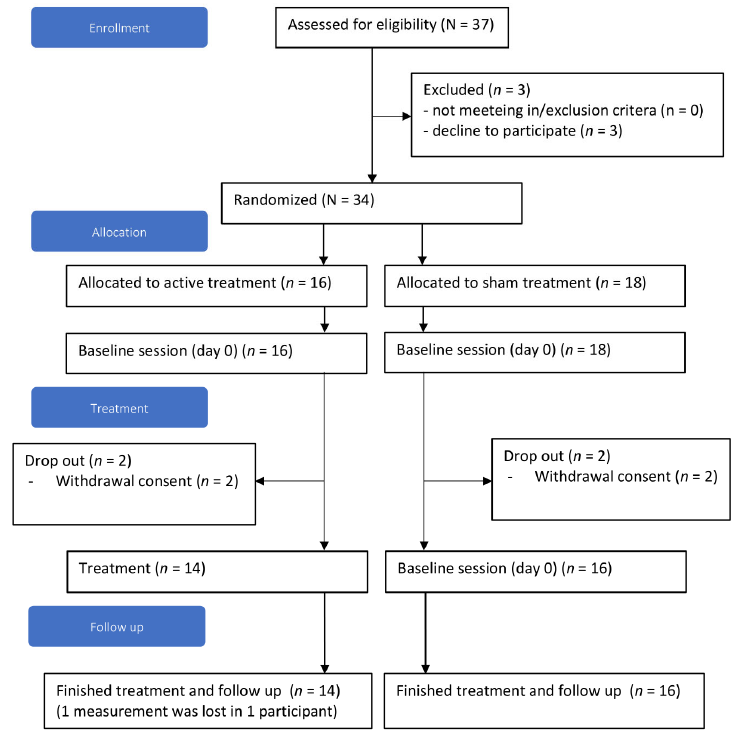
Figure 2. Consort Figure 2. Consort flowchart.